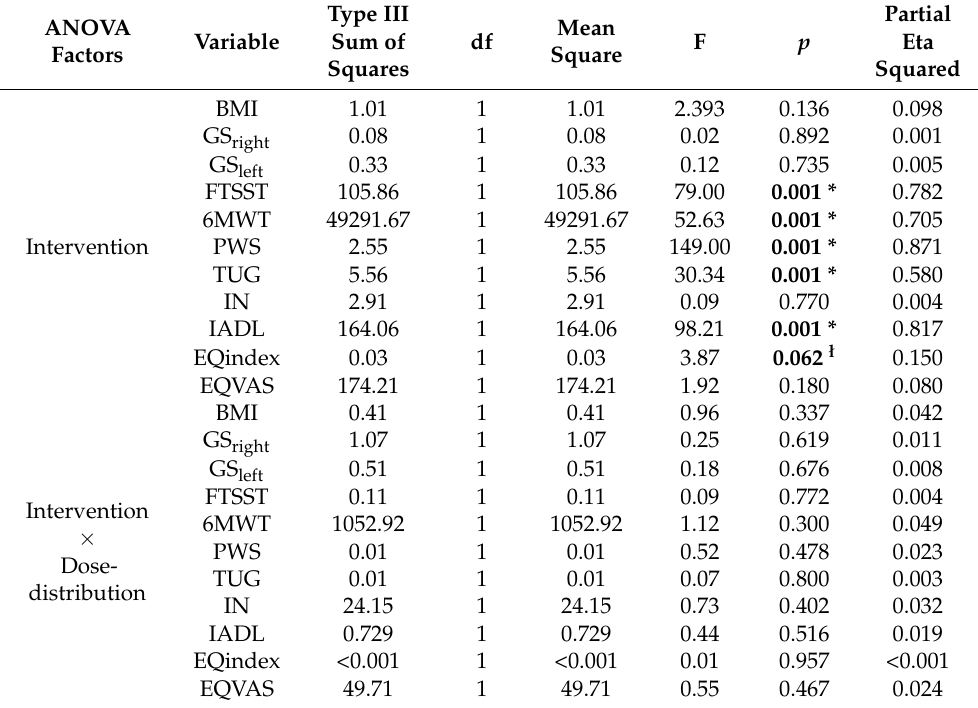
Table 2. Tests of within-subjects effects.